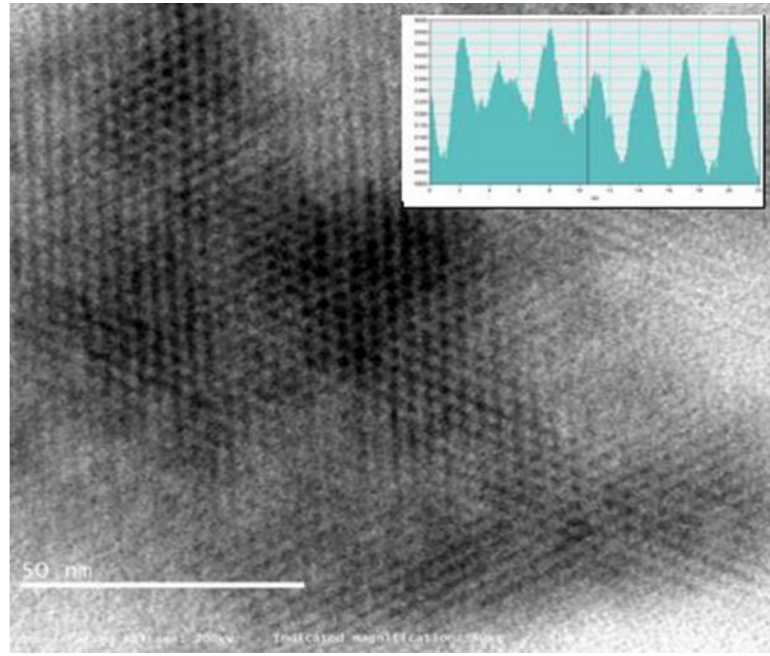
Figure 4. HR-TEM observation of graphene at 14,500×.